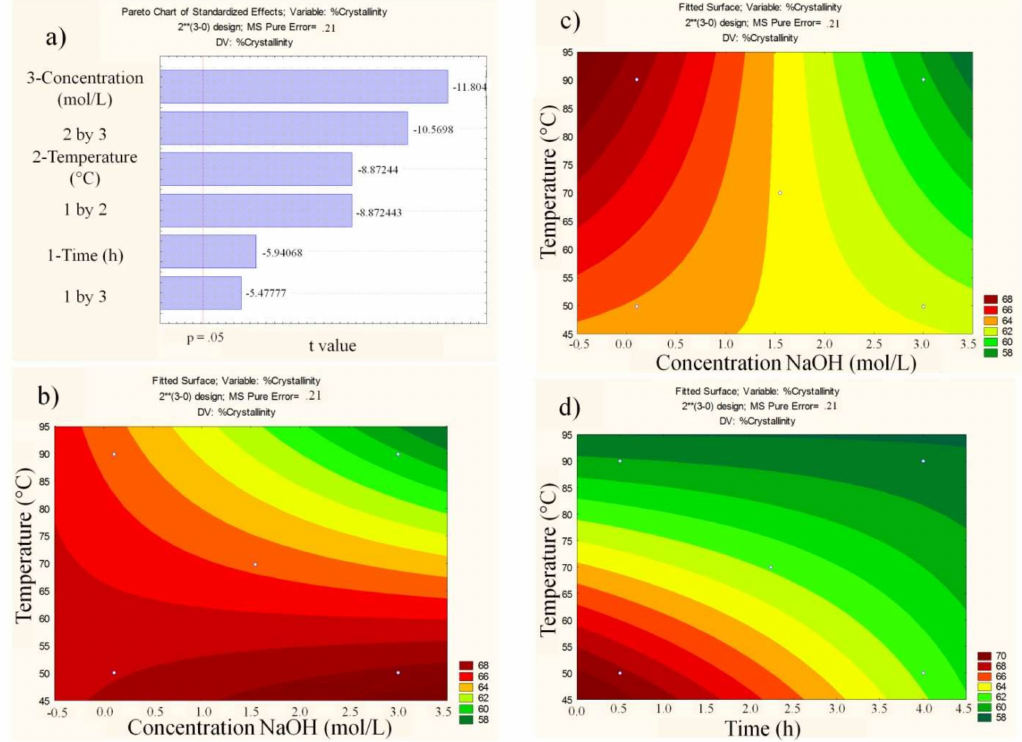
Figure 3. Statistical analysis. ( a ) Effect of the parameters on the response % crystallinity (Pareto chart). Response surface for ( b ) time = 0.5 h, ( c ) time = 4 h, and ( d ) concentration = 3 mol · L − 1